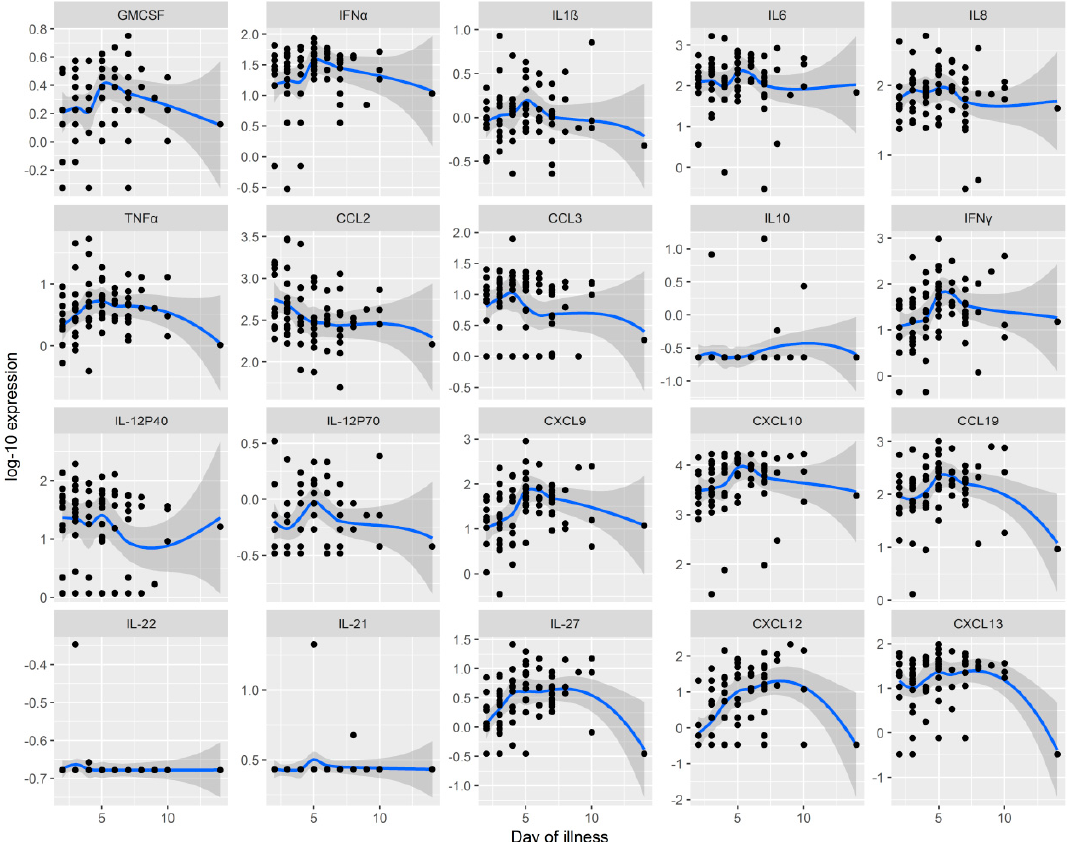
Figure 3. Dynamics Interplay between Inflammatory Immune Response in CSF and the Duration of the Early Meningoencephalitic Phase of the Illness. Four Representatives of Th17 Immune Response (IL-17, IL-17A, IL-23, and IL-25) are not Depicted Due to the Lack of Variability. The black dots represent individual values of the duration of early meningoencephalitic phase of the illness and the cytokine and chemokine levels in CSF for each patient. The (loess) blue curves estimate the functional association between the two variables using a non-parametric smoother, the gray bands are their 95% CIs.